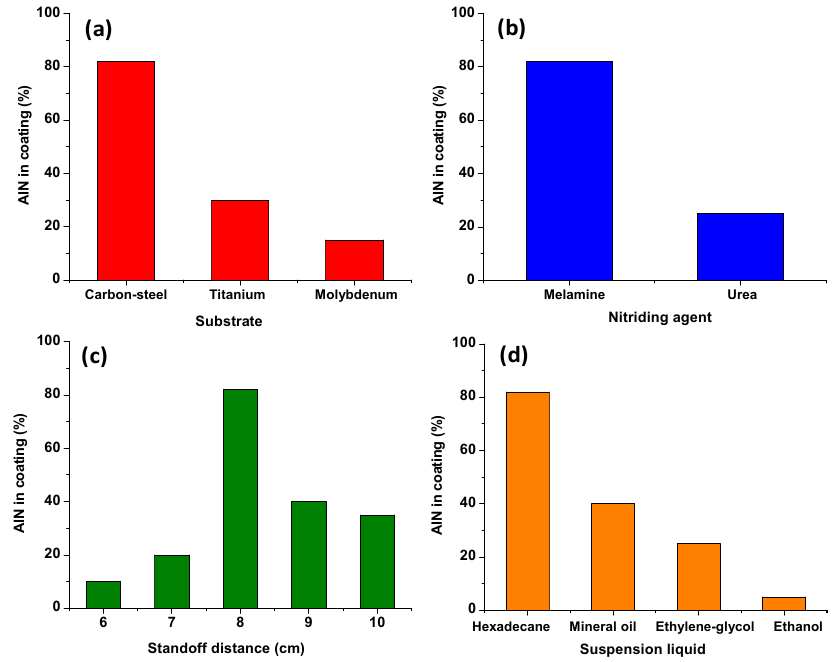
Figure 9. Calculated amount of AlN% in the coatings by RQA using XRD data where ( a ) shows the impact of different substrates; and by using carbon steel substrate, ( b ) the effect of nitriding agents; ( c ) different standoff distances and ( d ) the suspension liquid was studied.